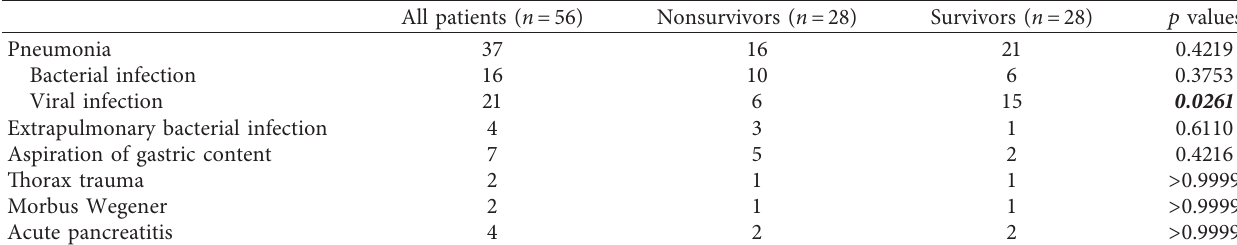
Table 3: Etiologies of acute respiratory distress syndrome.